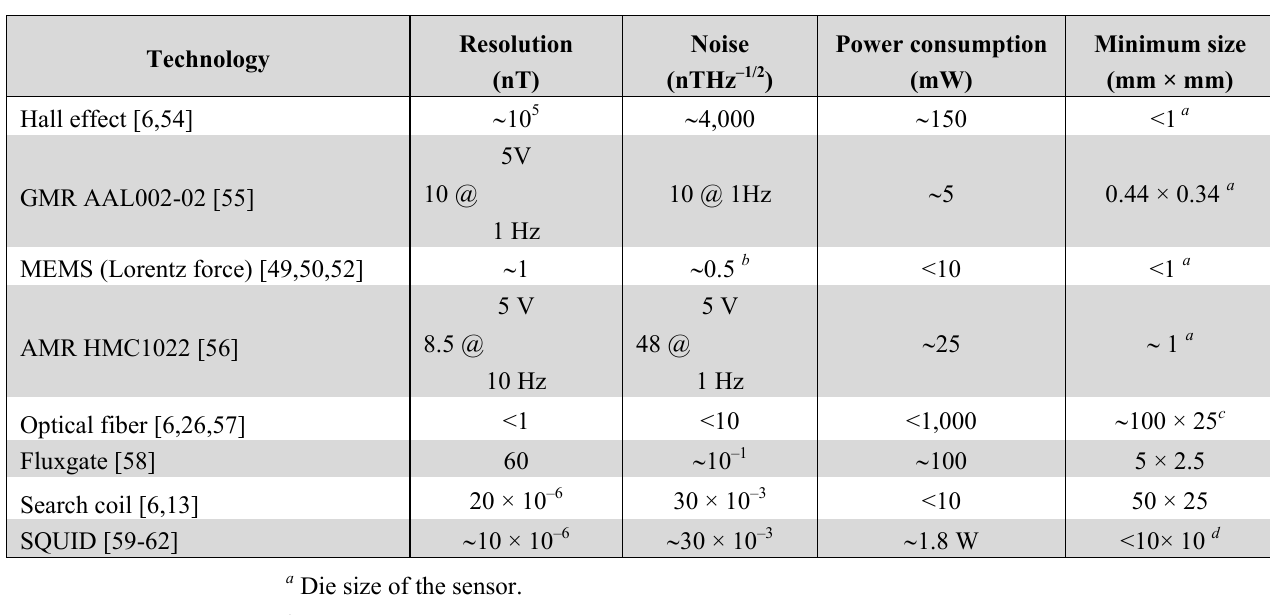
Table 2. Characteristics of some magnetic field